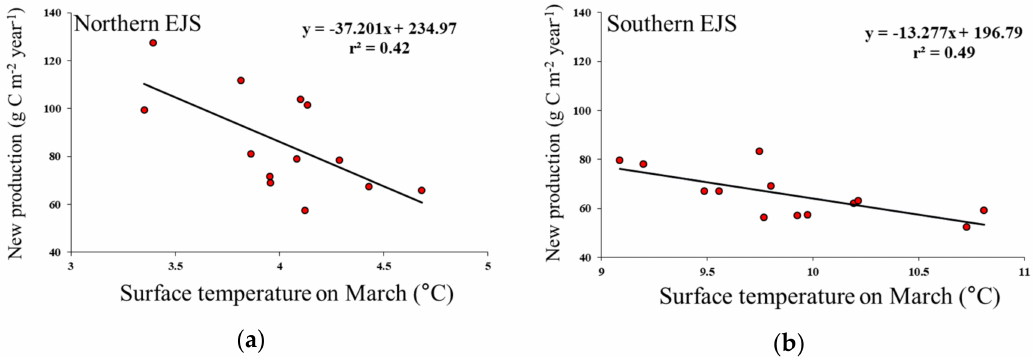
Figure 9. Relationships between the annual new production and Sea Surface Temperature (SST) in March in the northern ( a ) and southern ( b ) East/Japan Sea